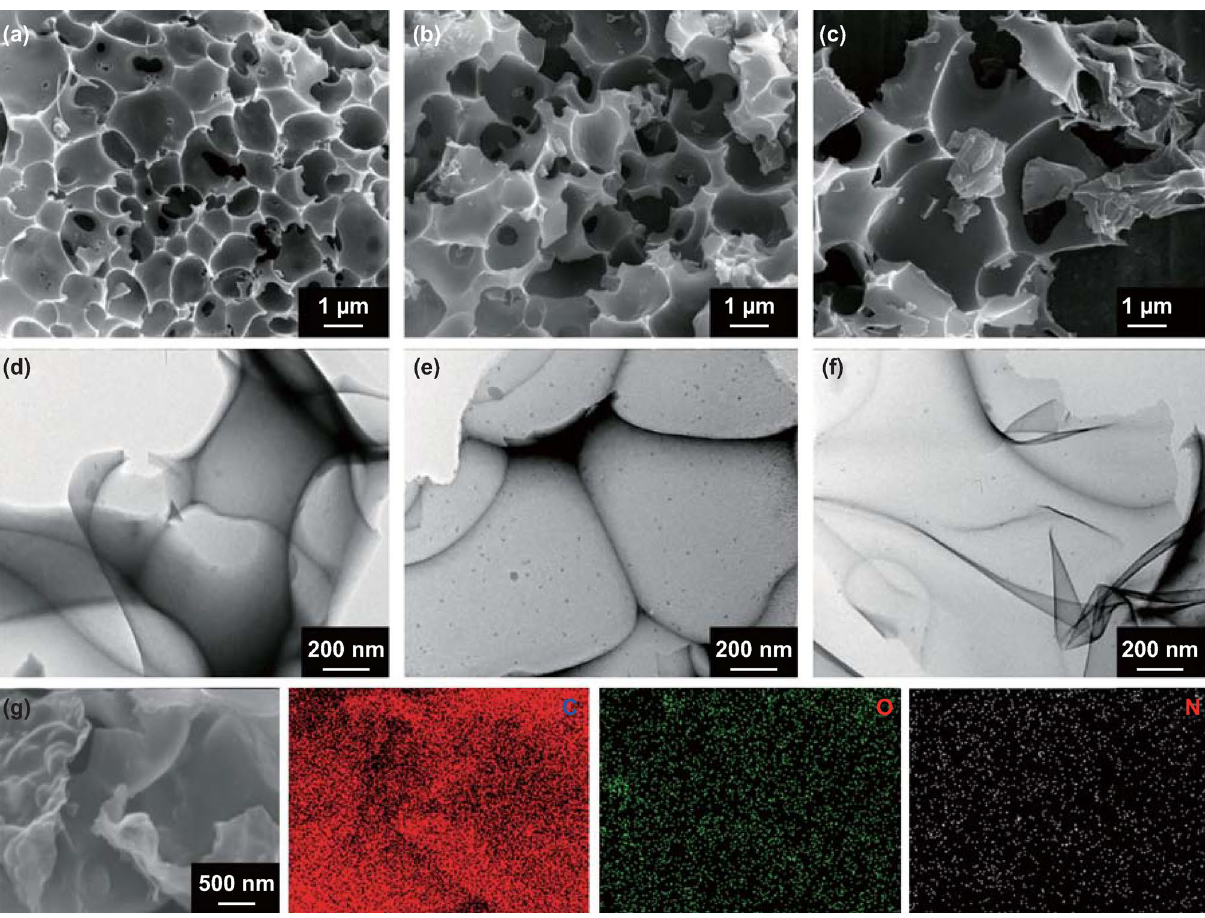
Fig. 1 FESEM images of a EBC 750 , b EBC 800 , and c EBC 850 . TEM images of d EBC 750 , e EBC 800 , and f EBC 850 . g FESEM image and corre- sponding EDS mappings of